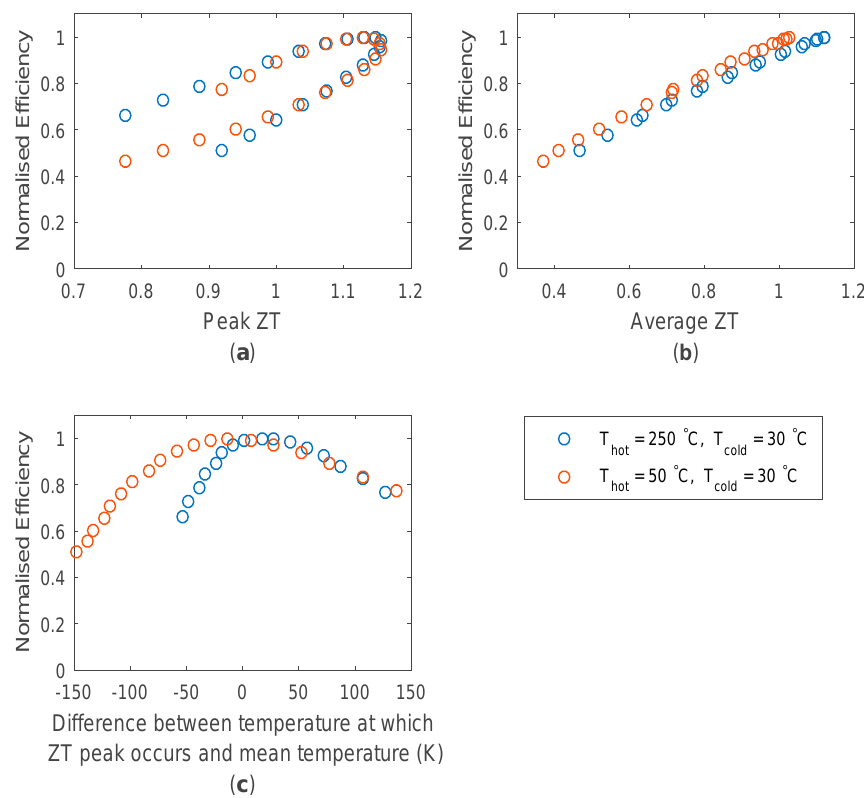
Figure 3. Calculated efficiency by finite element analysis (FEA), normalized to the maximum efficiency for the application, at different material doping levels (from 5 × 10 18 to 1 × 10 20 cm − 3 , logarithmically spaced) as a function of ( a ) peak ZT value; ( b ) average ZT value and ( c ) peak ZT position in temperature relative to the mean module temperature. Two different temperature applications are shown.